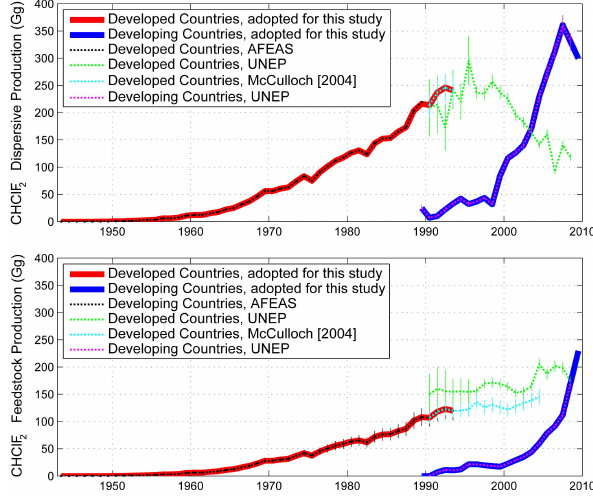
Fig. 3. Reported data for a) HCFC-22 (CHClF 2 ) production for dispersive uses and b) for feedstock use for developing and devel- oped countries as compiled from various sources and were used “as provided”. Data from UNEP, AFEAS and McCulloch (2004) are shown as dotted lines, while the red and blue solid lines denote the combined datasets adopted for use in this study. Pre-1990 feedstock data for developed countries were estimated as the AFEAS disper- sive production multiplied by developed countries feedstock over dispersive production ratio (McCulloch, 2004) from 1990. These adopted data were used to create the a priori emission history for the 2-D model inversions. The subset of these data used to create the “bottom-up” HFC-23 emission history (1990-2008) is tabulated in Table 4. Uncertainties ( ± 1 σ) for these data are denoted by error bars and are listed in Table